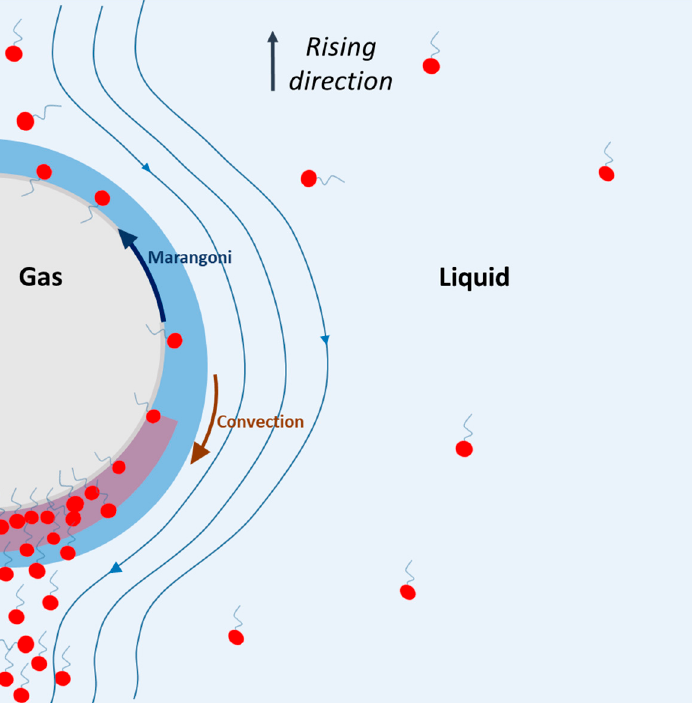
Figure 8. Representation of physical phenomenon occurring during the rising of a bubble in surfactant solution, according to the theory presented in this